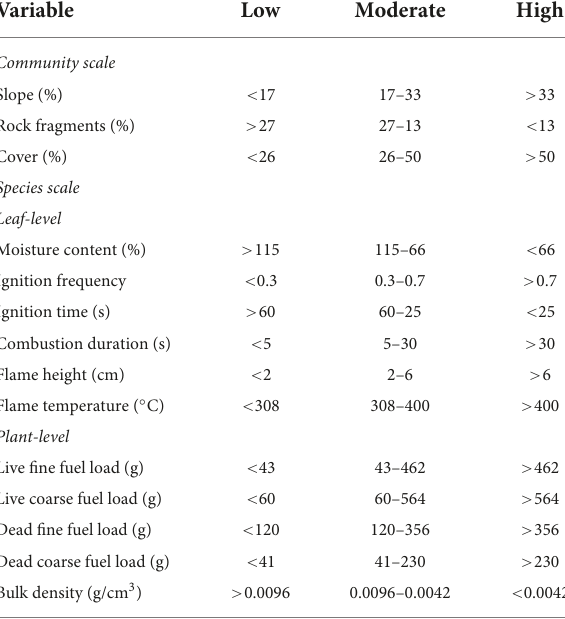
TABLE 2 Categories of the variables used in the multiple correspondence analysis and the ascendant hierarchical classification analysis at community and species